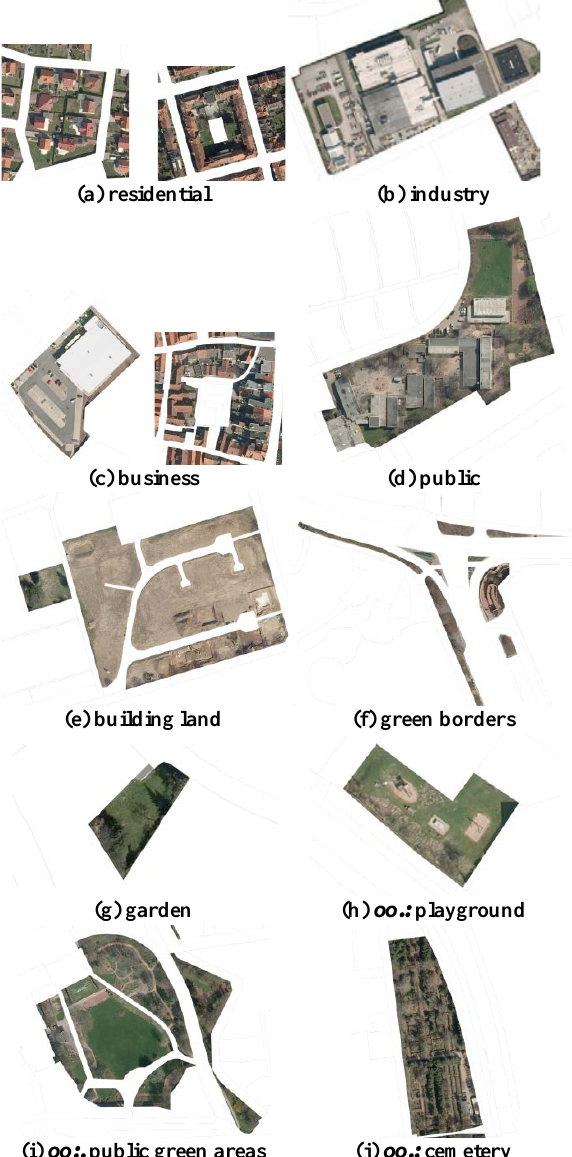
Figure 1. Examples of some subcategories of the main land use categories settlement (a-d) and others